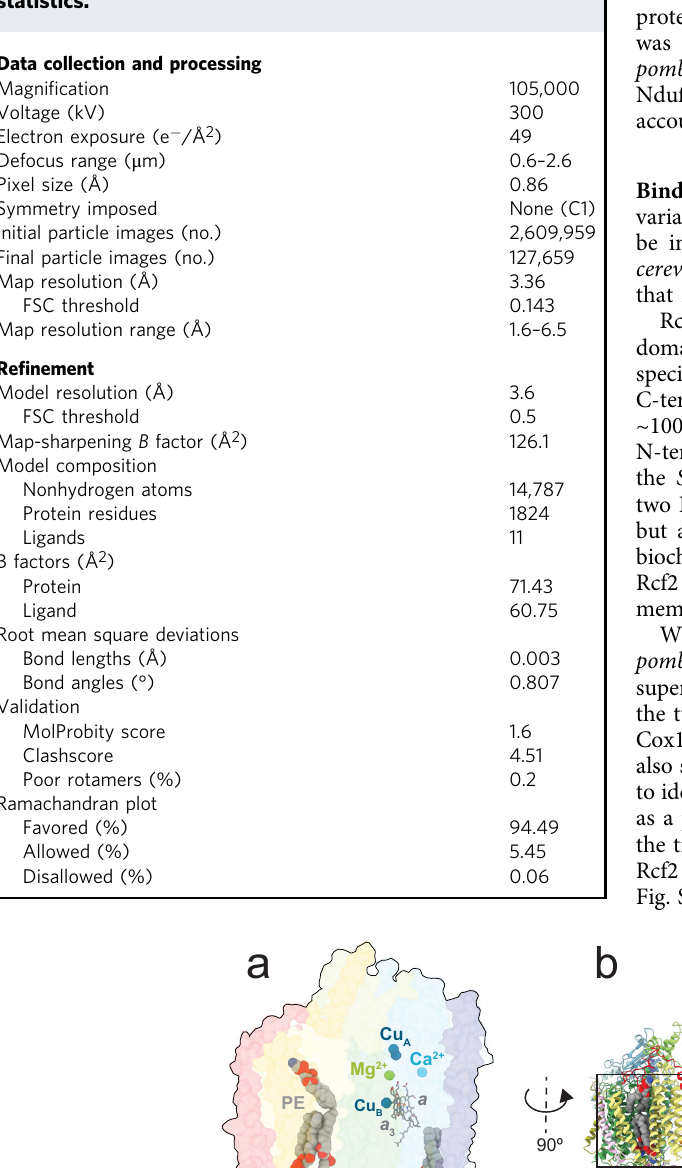
Table 2 Cryo-EM data collection, re fi nement and validation statistics.